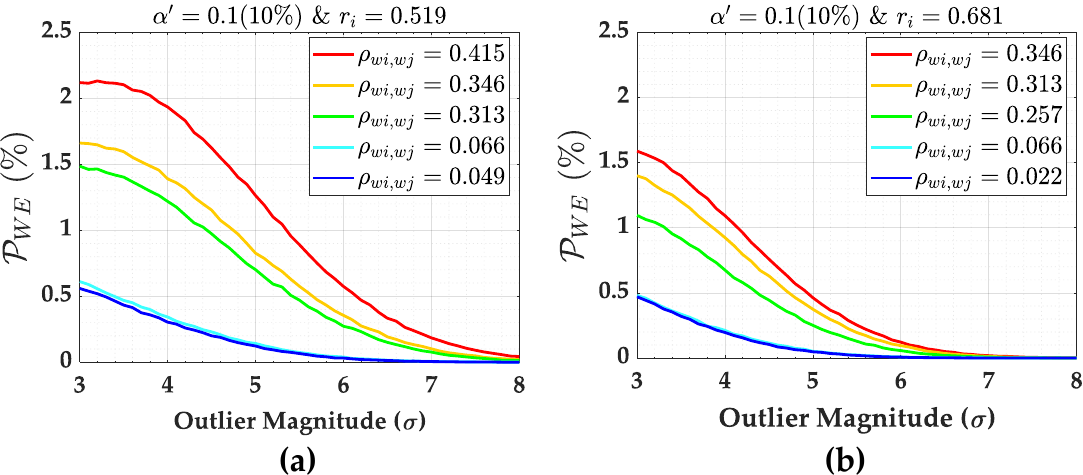
Figure 11. Individual contribution of external and internal connections to the overall P WE and their relationship with the correlation coefficient ρ w for network ( a ). ( a ) Individual contribution to P WE i , w j by external connections. ( b ) Individual contribution to P WE by internal